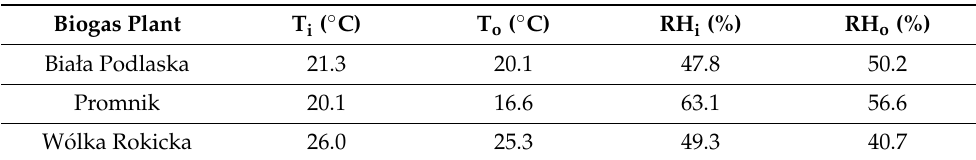
Table 3. The results of microclimate parameter